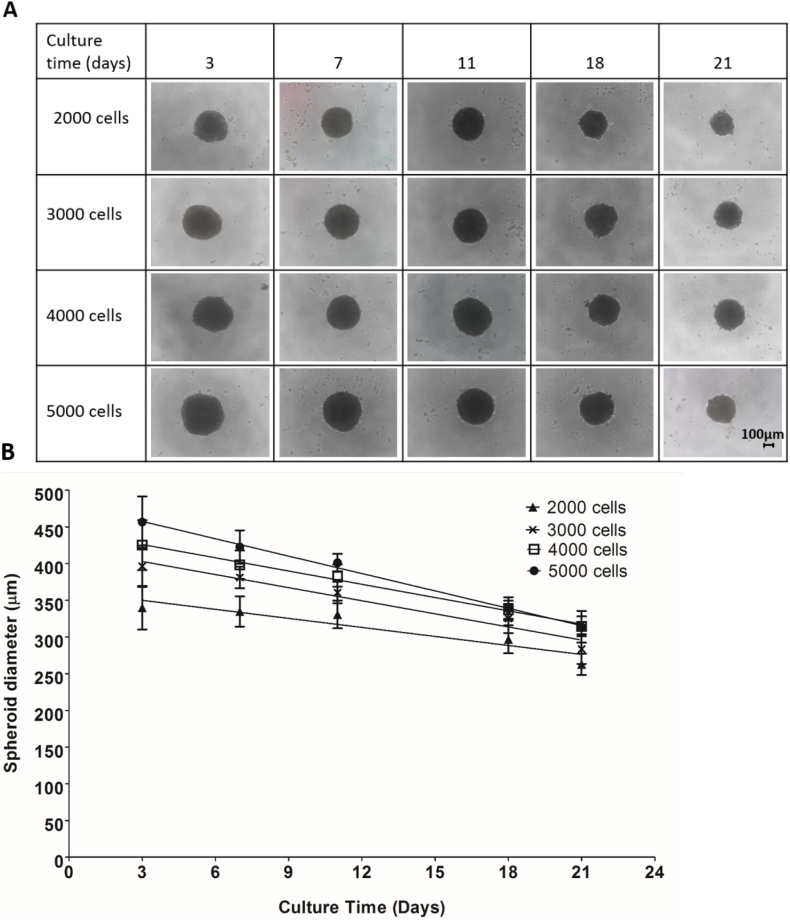
Effect of initial cell seeding density on spheroid size and morphology. Spheroids were produced from seeding 2000, 3000, 4000 and 5000 PRH per well in 100 μl complete Williams' medium E and cultured for up to 21 days. (A) phase-contrast images of spheroids taken at time points (3, 7, 11, 18, and 21 days). Scale bar = 100 μm. (B) compaction of spheroids/reduction of spheroid diameter over 21-day culture period. Data are represented as mean ± SD (n = 10 in triplicate). Straight lines represent linear regression analysis using Graphpad prism. R2 values were 0.768, 0.9569, 0.9928 and 0.9957 for 2000-, 3000–4000- and 5000-cell spheroids respectively.